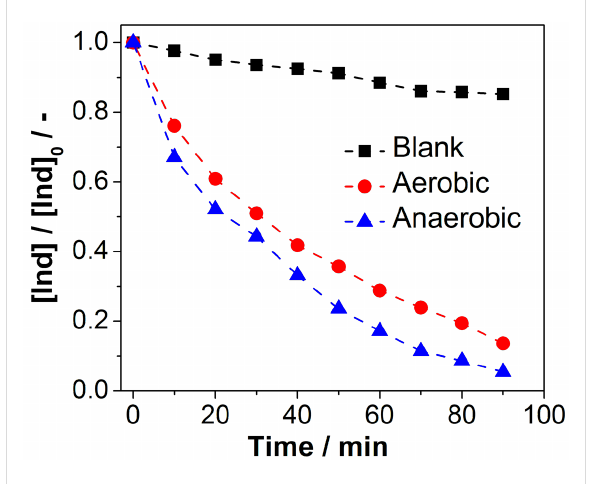
Figure 2: Photooxidative performance of 1 under anaerobic (blue triangles) and aerobic (red circles) conditions in the homogeneous photooxidation of indigo (Ind). Solvent: DMF, light source: monochro- matic LED ( λ = 430 nm, P nominal = 3 W), [1] = 1.0 μ M, [Ind] 0 = 5.0 μ